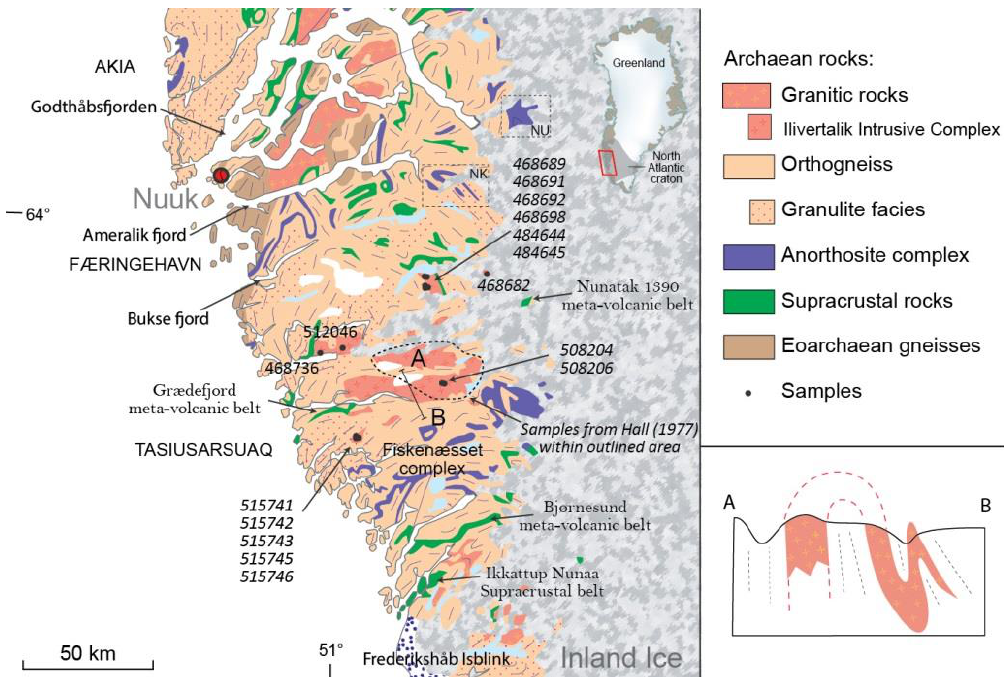
Figure 1. Simplified geological map of a section of the Archaean basement in southern West Greenland, where Ilivertalik intrusive complex (IIC) outcrops within the Tasiusarsuaq terrane (TT). As seen in the insert, IIC outcrop as isoclinal folded [22]. Anorthosites of the Fiskenæsset Complex (FC) are situated just south of the main IIC intrusion. Another belt of anorthosites, found at the northern limit of TT, includes the Nunataarsuk (NU) and the Annjat Kuuat (AK) anorthosite complexes which are also of similar age as FC [23,24]. Map is modified from